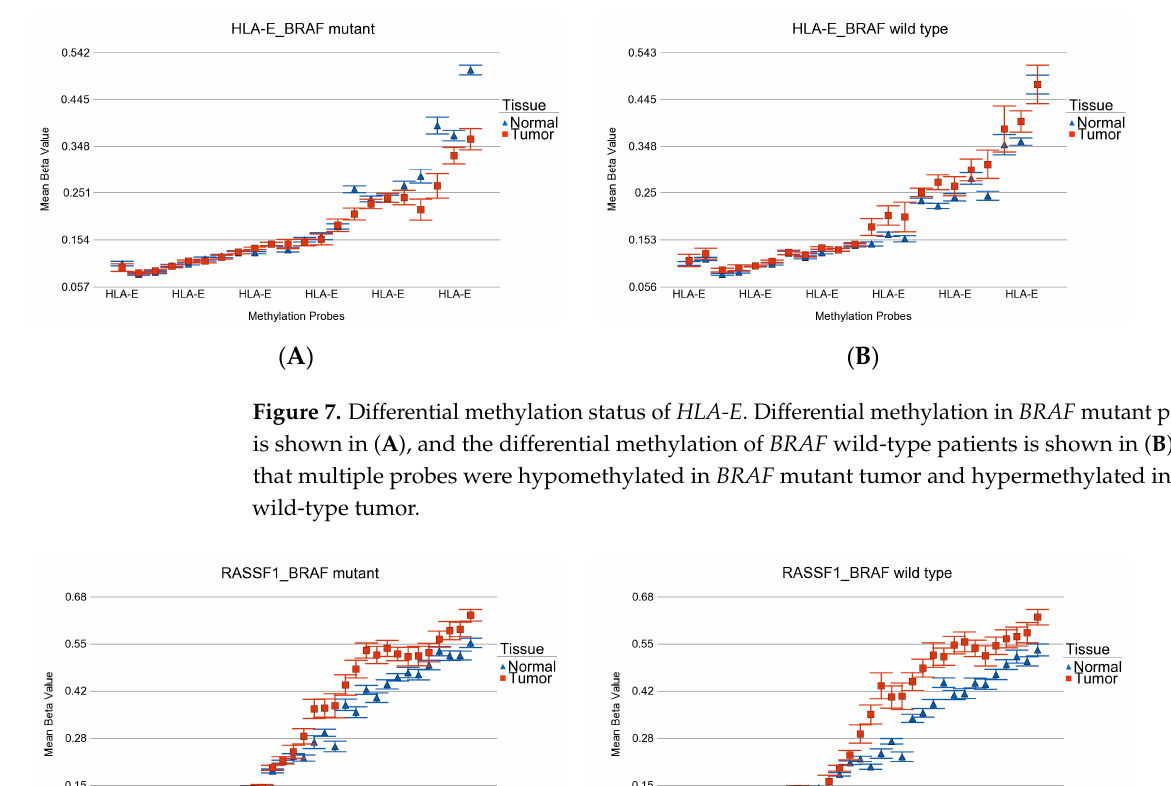
Figure 7. Differential methylation status of HLA-E . Differential methylation in BRAF mutant pa- tients is shown in ( A ), and the differential methylation of BRAF wild-type patients is shown in ( B ). Note that multiple probes were hypomethylated in BRAF mutant tumor and hypermethylated in BRAF wild-type tumor.